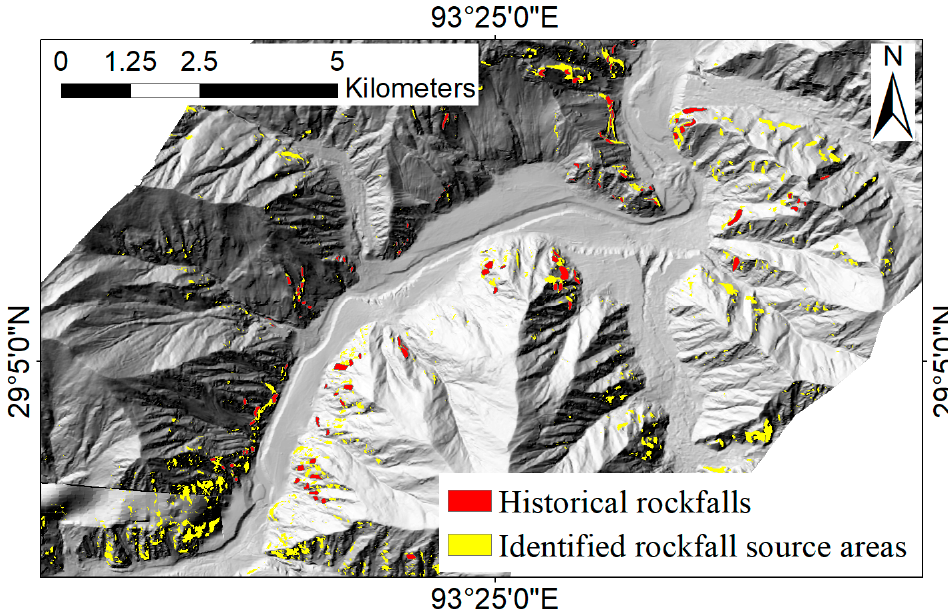
Figure 8. The validation of the prediction result obtained by using one group of historical rockfalls separated by the space partition (Figure 1a).